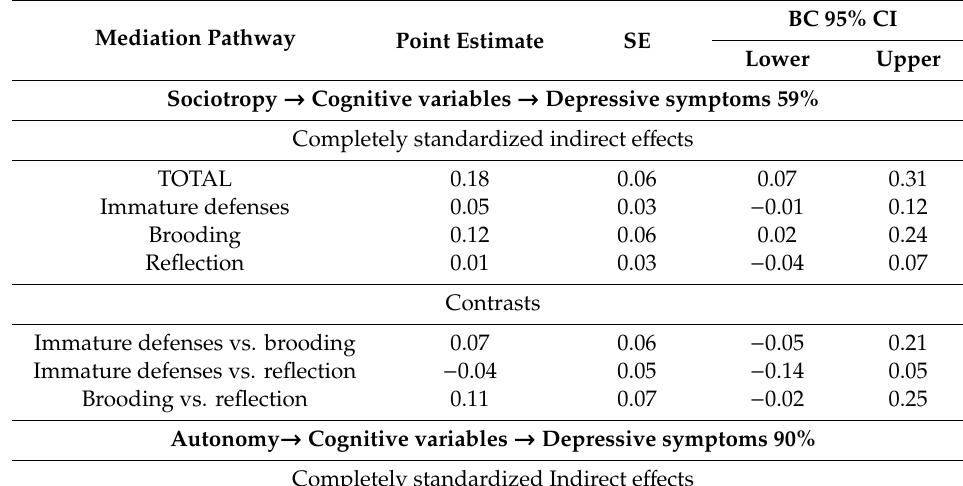
Table 2. Results of multiple mediation analysis of the relation between sociotropy and autonomy, respectively, and depressive symptoms in patients with MDD ( n =